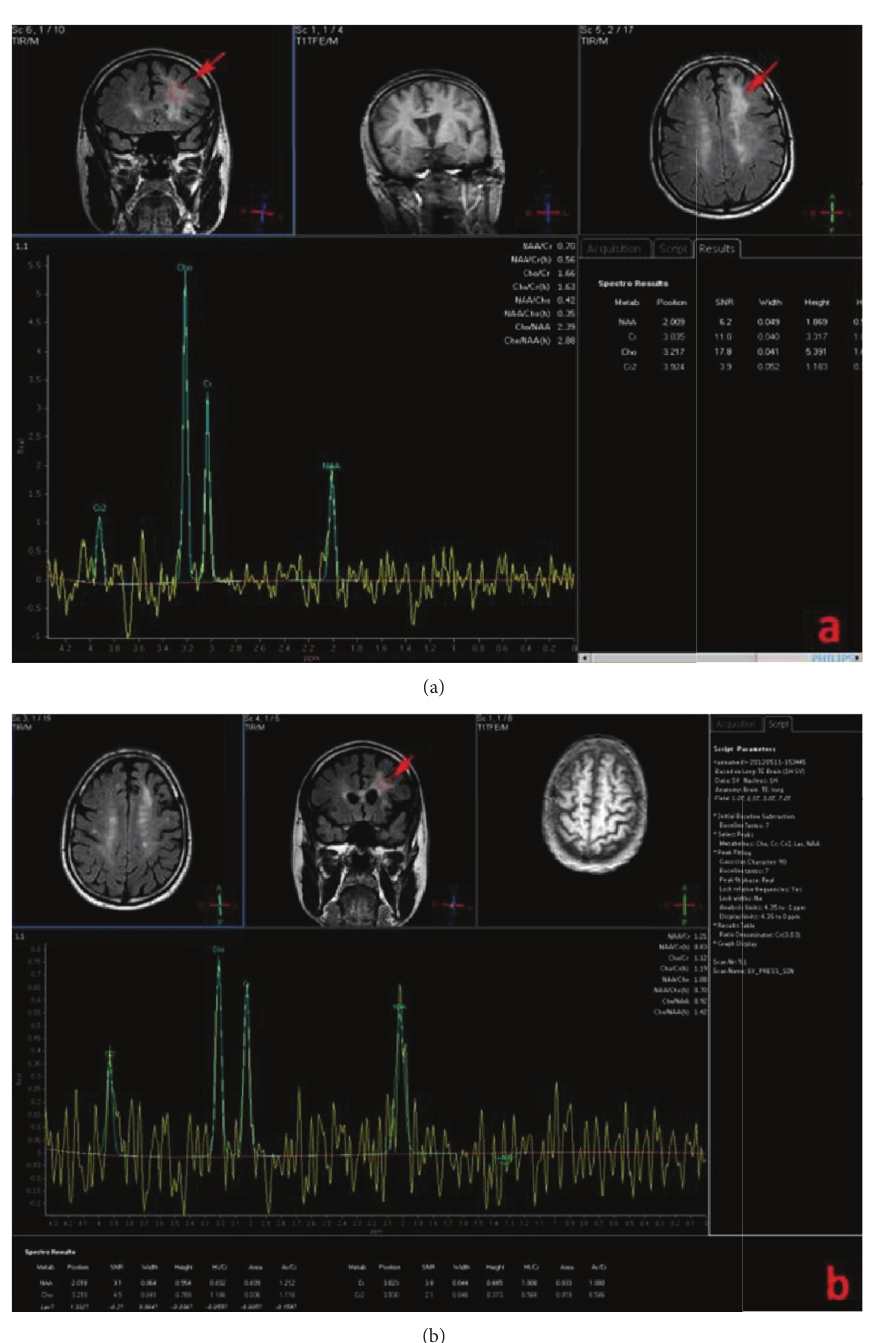
Figure 4: MRS (Philips Achieva 3T, TR/TE = 2000/40, increased choline, inverted Cho/Cr ratio, decreased N-acetyl-aspartate between December 2011 (a) and May 2012 (b) of the white matter lesion underneath the frontal lobe of the left hemisphere (arrows) at MRS in a 44-year-old man with a 12-year history of MS affected by natalizumab-related PML. May 2012 MRS showed a decrease in Cho/Cr ratio and increased